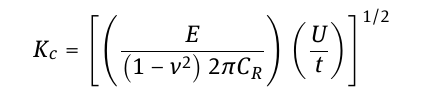
the energy difference before and after crack generation is estimated as area